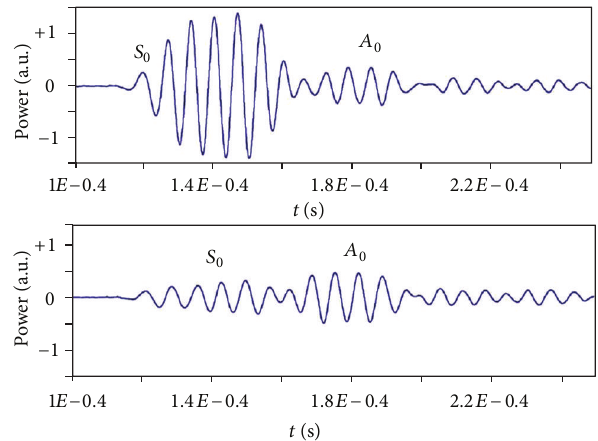
Figure 24: Lamb wave signals obtained by the polarimetric method for different polarizer orientations: top − 10 ∘ to the plane of the plate and bottom − 60 ∘ orientation [14].